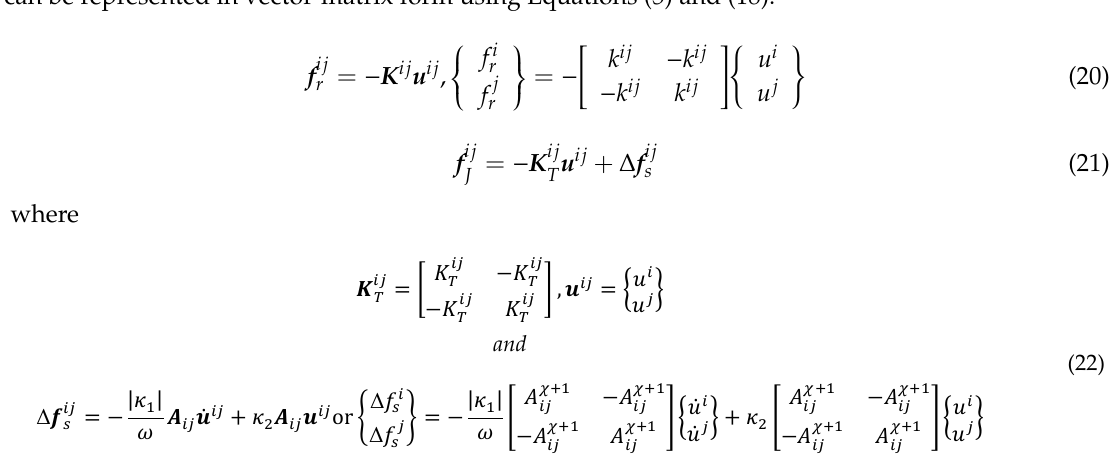
Figure 2. Description of the 2 DOF system connected by the stiffness k and the Iwan model between the i th and j th